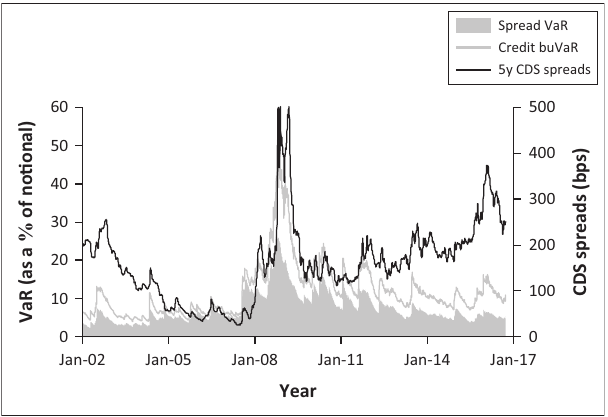
FIGURE 4: Credit risk measures on five-year credit default swap spreads using the EWMA approach as a measure of volatility ( ω